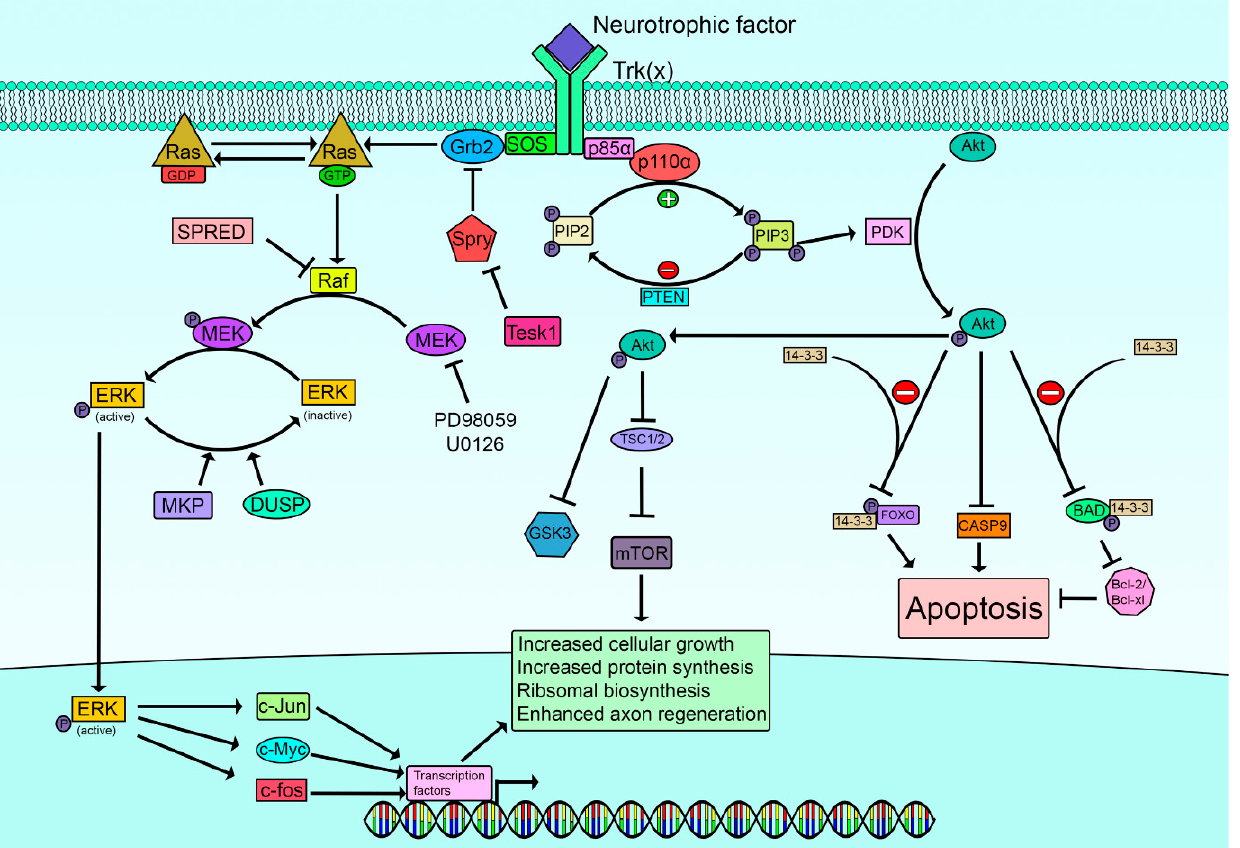
Figure 2. Overview and simplified schemata of the major molecular pathways downstream of neurotrophin growth factors, binding to their Trk receptors, that converge on transcriptional activation.